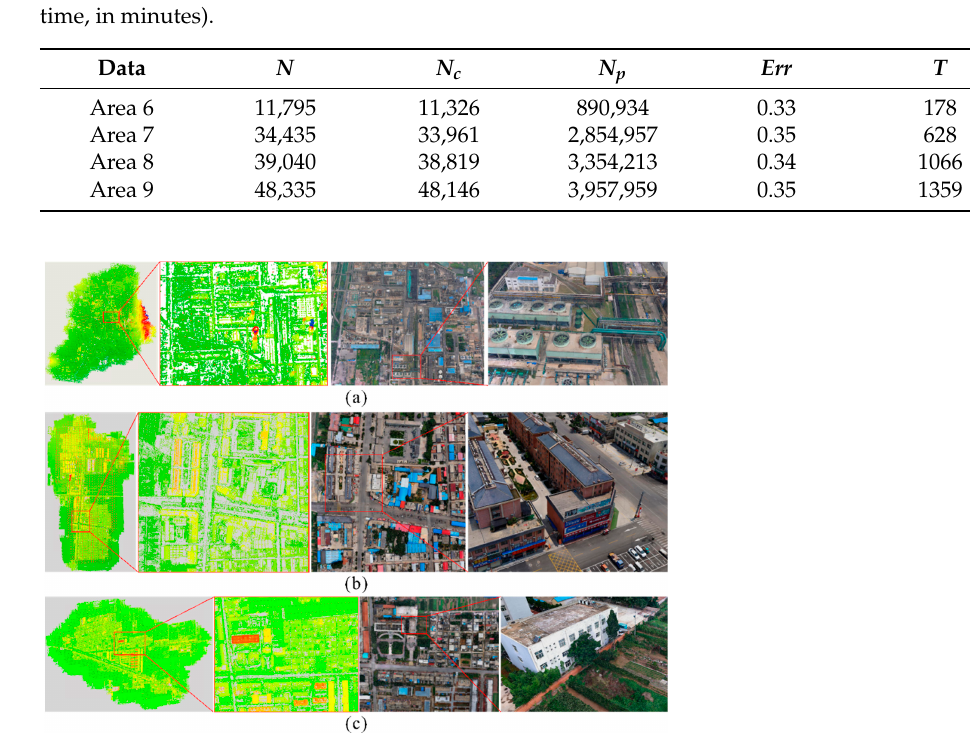
Figure 8. Reconstruction results for large-scale ariel datasets. The leftmost is the overall display of the sparse reconstruction results, the middle-left is the local detail display of the sparse reconstruc- tion results, the middle-right is the 3D model reconstruction results corresponding to the middle- left, and the rightmost is the detail display of the 3D model reconstruction results. ( a ) The result of oblique image dataset Area 7; ( b ) the result of oblique image dataset Area 8; ( c ) the result of oblique image dataset Area